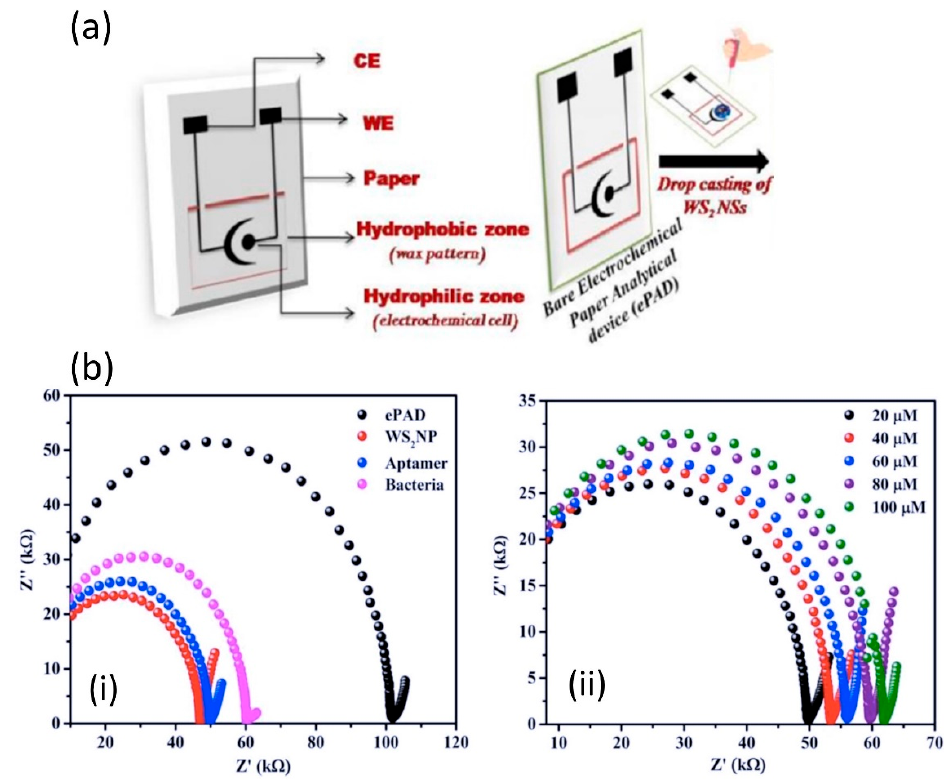
Figure 8. ( a ) Fabrication of screen-printed sensor on paper-based substrate is also well-known as paper-based analytical device (ePAD) and ( b - i ) Nyquist plot of bare ePAD, ePAD/WS 2 NS, after immobilization with aptamer and after immobilization with bacteria, ( b - ii ) Nyquist plot of detection bacteria at different concentration ranging from 20 µ M to 100 µ M. Reprinted with permission from [161]. Copyright 2021 MDPI. Authors licensed under a Creative Commons Attribution (CC BY) license.